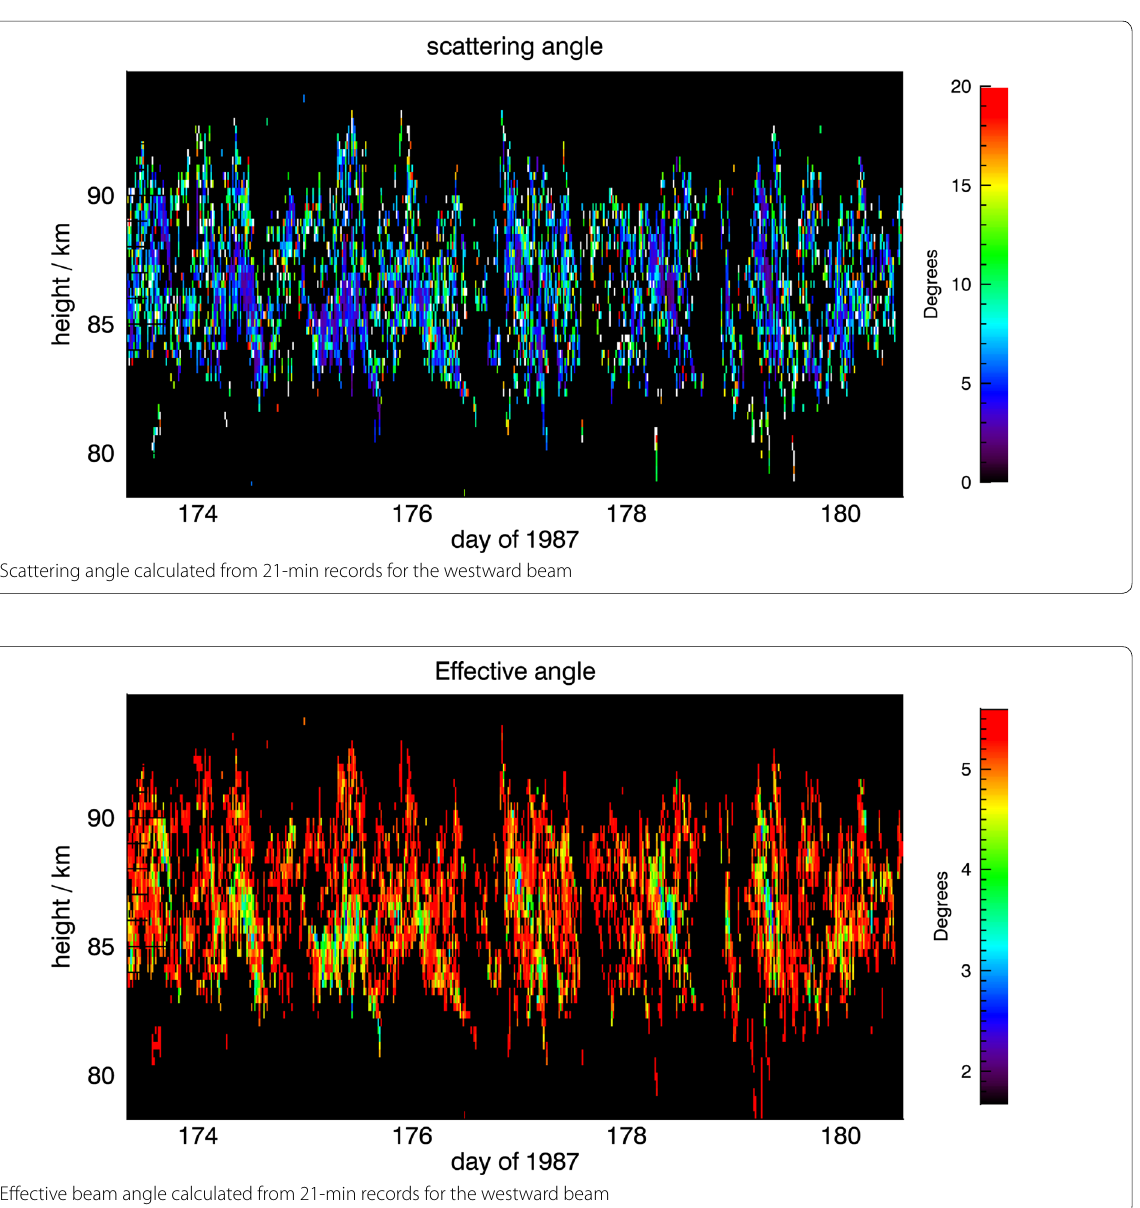
Fig. 4 Effective beam angle calculated from 21-min records for the westward